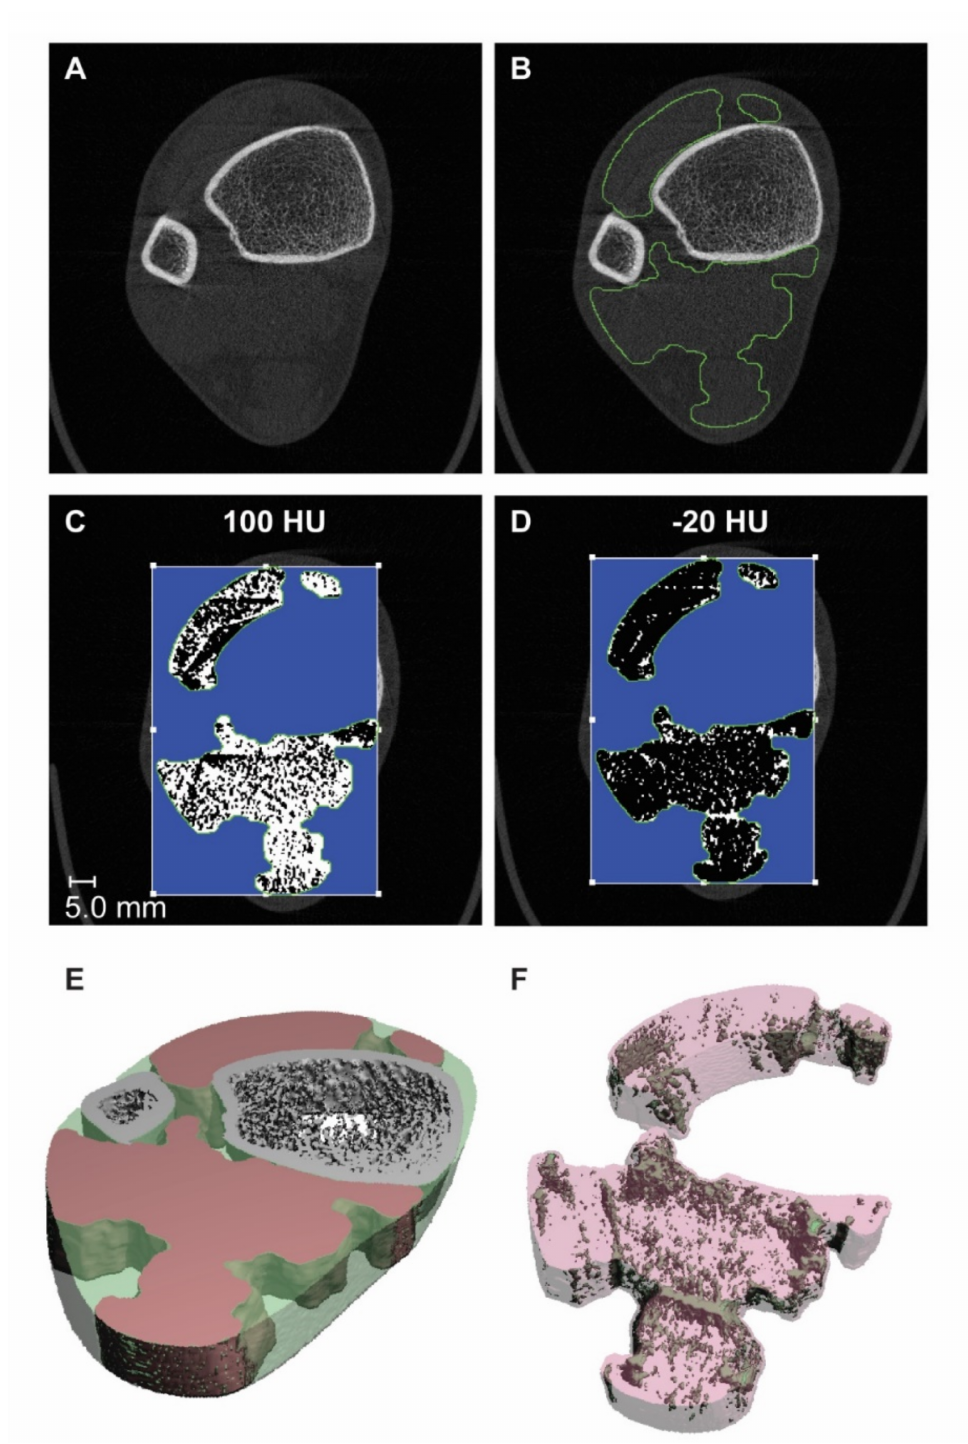
Figure 1. Representative images showing representation of the IMAT analysis protocol and the resulting 3D images. ( A ) In the original image, the ROI was selected using the muscle contours determined by the STA protocol, which is ( B ) depicted in green. ( C ) The intended segmentation threshold with an upper threshold of 100 HU did not produce a realistic result and was, therefore, rejected. ( D ) The upper threshold of − 20 HU was defined manually. ( E ) The STA protocol produces a 3D segmentation, with the bones depicted in grey, the muscles in red, and fat in transparent green. ( F ) Application of the IMAT segmentation produces a 3D image, as shown with the IMAT depicted in green and the muscle depicted in transparent